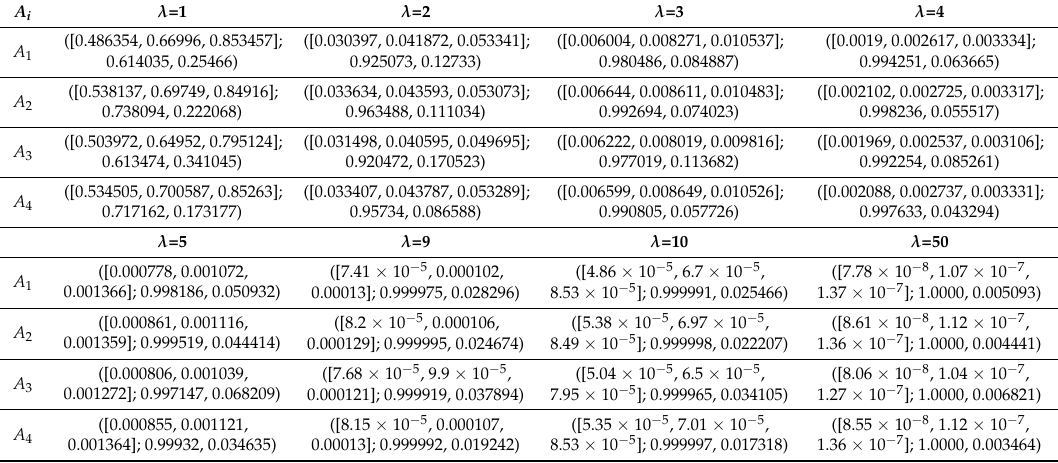
Table 3. The overall preference values (comprehensive evaluations for four alternatives).